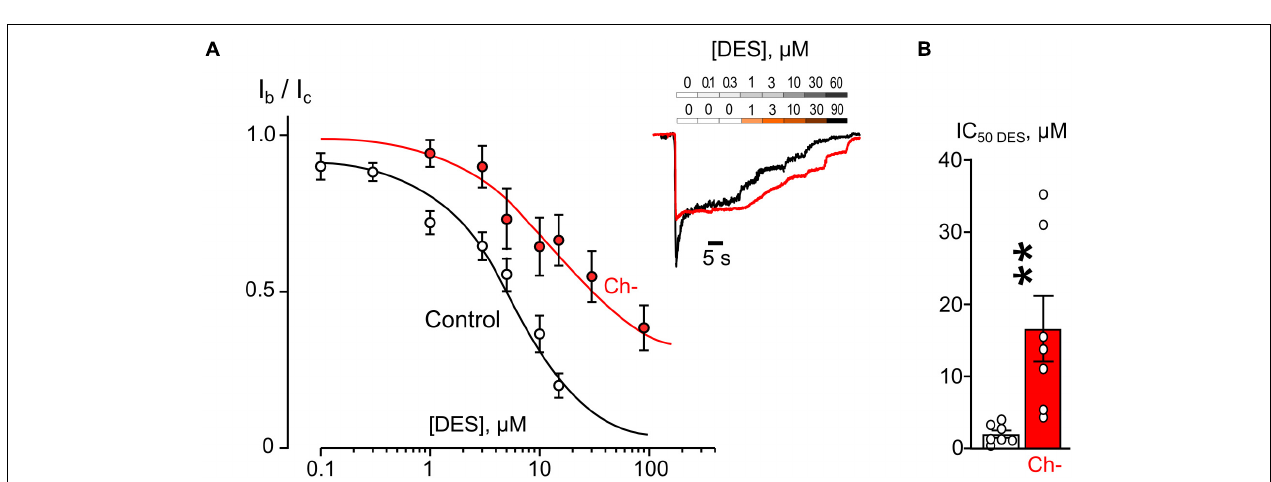
FIGURE 5 | Plasma membrane cholesterol extraction by M β CD affects inhibition of NMDAR currents by desipramine (DES). (A) Concentration-inhibition curves for DES effect on currents activated by 100 µ M NMDA + 30 µ M Gly obtained in 2 mM [Ca 2 + ] in control, after cholesterol extraction with M β CD (Ch − ). Symbols show mean values ± SEM of the relative amplitudes of currents (I b /I c ) in the presence (I b ) and absence (I c ) of different DES concentrations. In insert sample traces of NMDAR currents normalized to the steady-state amplitude without DES, recorded at –70 mV in the presence of increasing DES concentrations in control (upper row) and after M β CD treatment (lower row). (B) Mean IC 50 s for DES inhibition of NMDAR currents in control and cholesterol depleted (Ch − ) neurons derived from data illustrated on (A) . Data obtained in cholesterol depleted cells differ significantly from these of control (** p = 0.0082), unpaired Student’s t -test. Data from each experiment (symbols) and mean values ± SEM are shown. The IC 50 values are summarized in Table 1